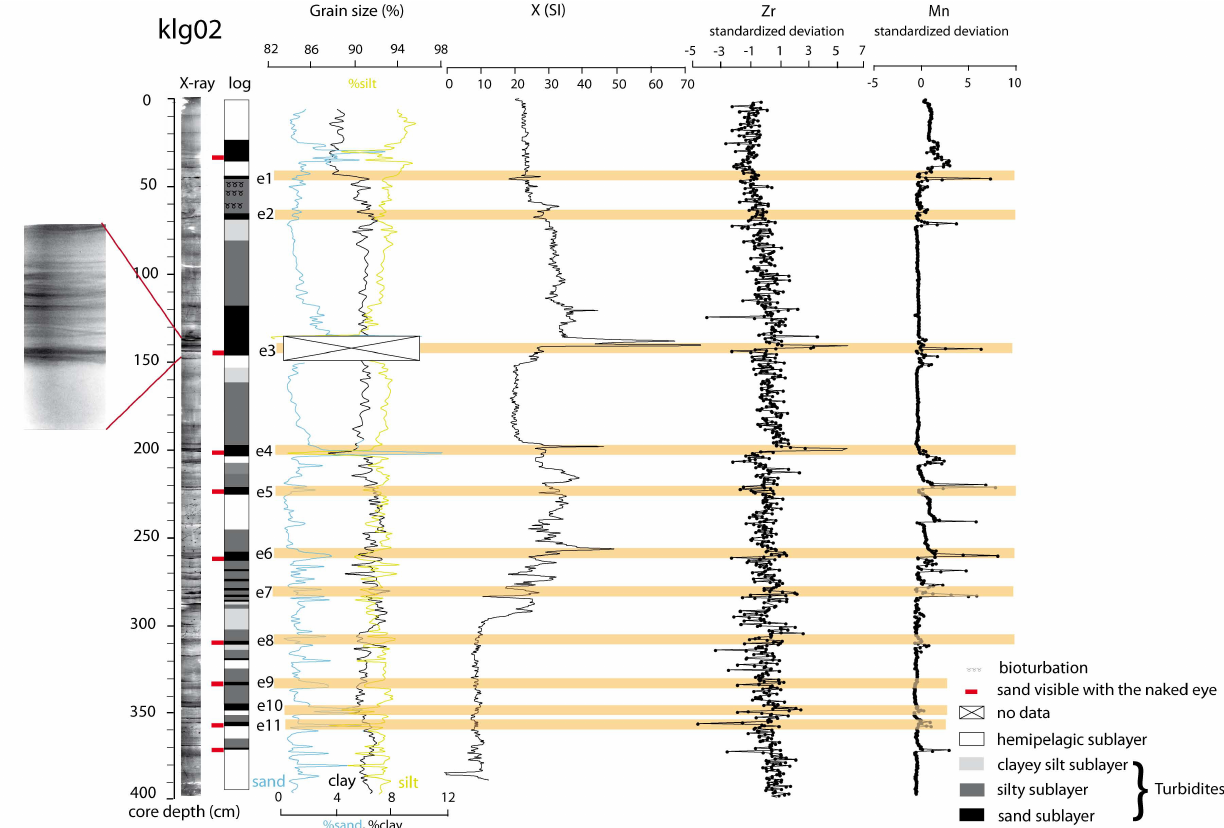
Fig. 5. Stratigraphic log of the Klg02 core in the Central Basin obtained by combining X-ray imagery, grain size, magnetic susceptibility data, Mn and Zr standardized intensities. On the left, zoom in the X-ray of the basal layers of the thickest turbidite e3 with complex laminations. Main turbidites deposits are identified and labelled; event labels change according to their stratigraphic position, beginning with 1 at the top of the core. Sandy sublayers are represented in black, intermediate silty sublayers in grey, upper clay-rich sublayers in light grey and background sedimentation in